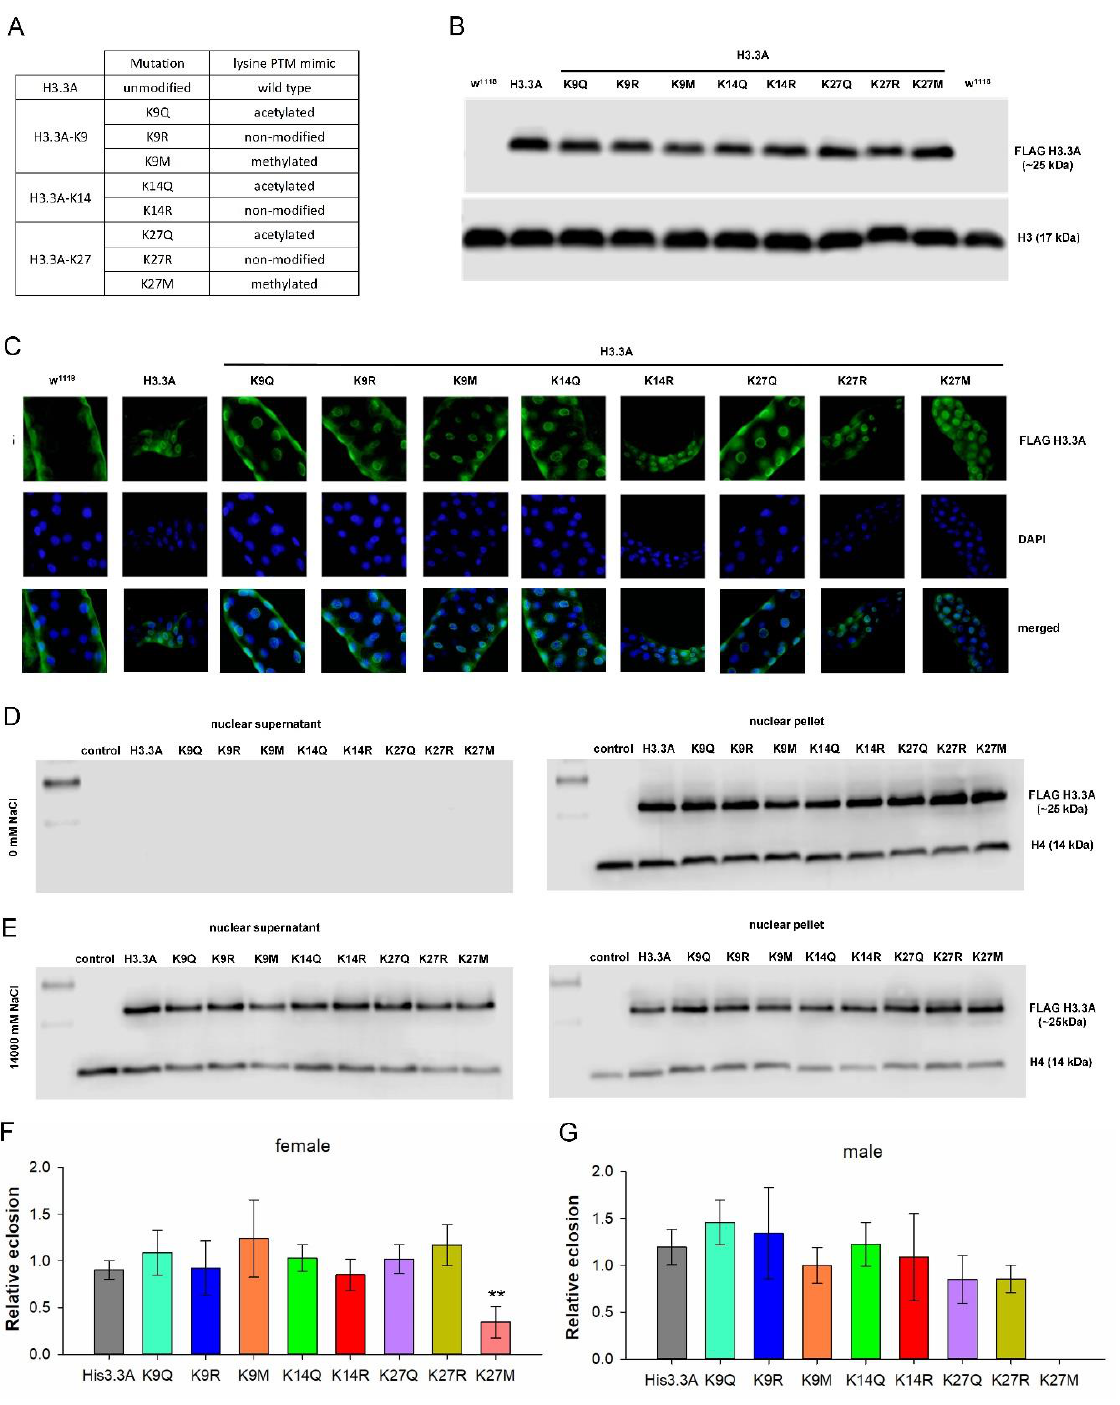
Figure 1. H3.3 PTM mimetic mutant histones are expressed at similar levels and show nuclear localization. Except for H3.3-K27M modification elav-GAL4 -driven expression of H3.3-PTM, mimetic mutant histones do not affect the viability of wild-type flies. ( A ) List of generated transgenic flies mimicking lysine post-translational modifications of H3.3. Lysine mutated to glutamine (K → Q) mimics an acetylated state, lysine mutated to arginine (K → R) mimics a non-modified state, and lysine mutated to methionine (K → M) mimics a methylated state. ( B ) Immunoblot analysis of head samples of female flies overexpressing His3.3A or His3.3A-PTM transgenes using anti-FLAG antibody recognizing the C-terminal FLAG-tag. All transgenes produced full-length H3.3 proteins at